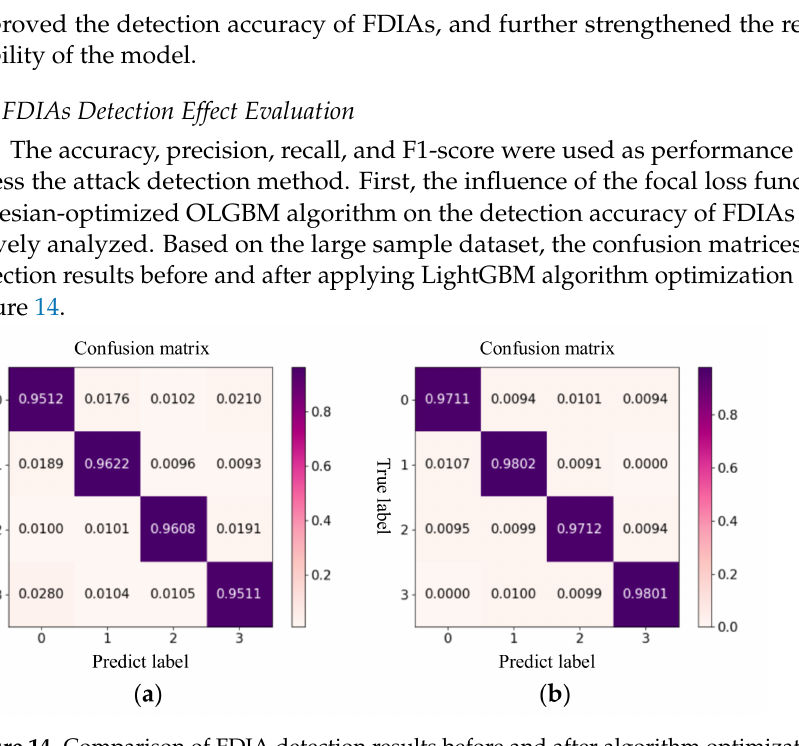
Figure 14. Comparison of FDIA detection results before and after algorithm optimization. ( a ) Before algorithm optimization; ( b ) after algorithm optimization.